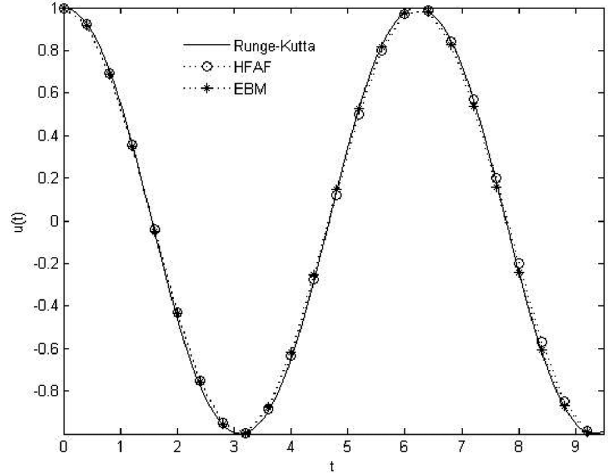
Fig. 9. The comparison between frequency-amplitude formulation with Runge-Kutta 4 th order and energy balance solutions when λ = 1 and A = 1, for the fi rst mode.